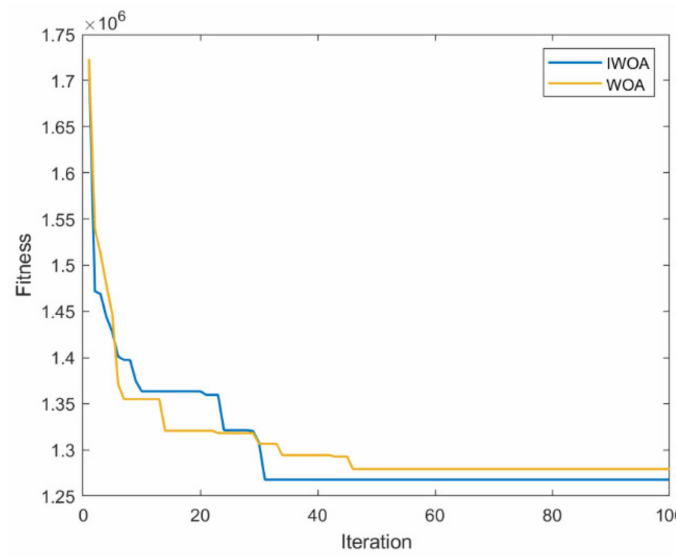
Figure 27. Convergence curve.